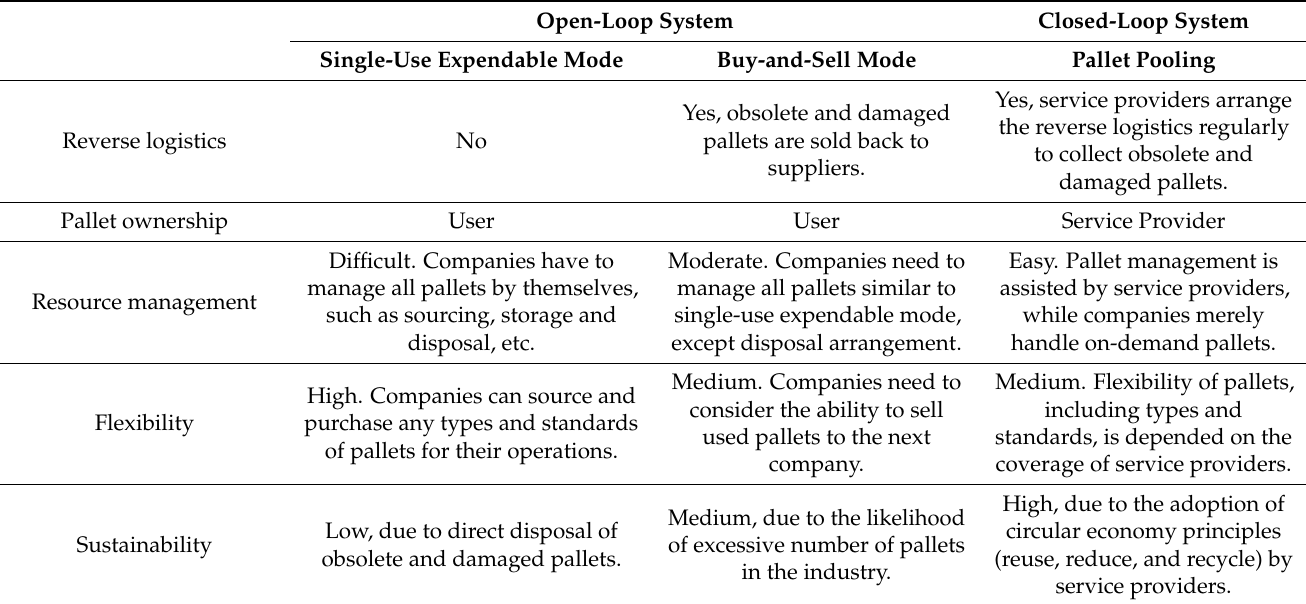
Table 1. Comparison of various pallet management